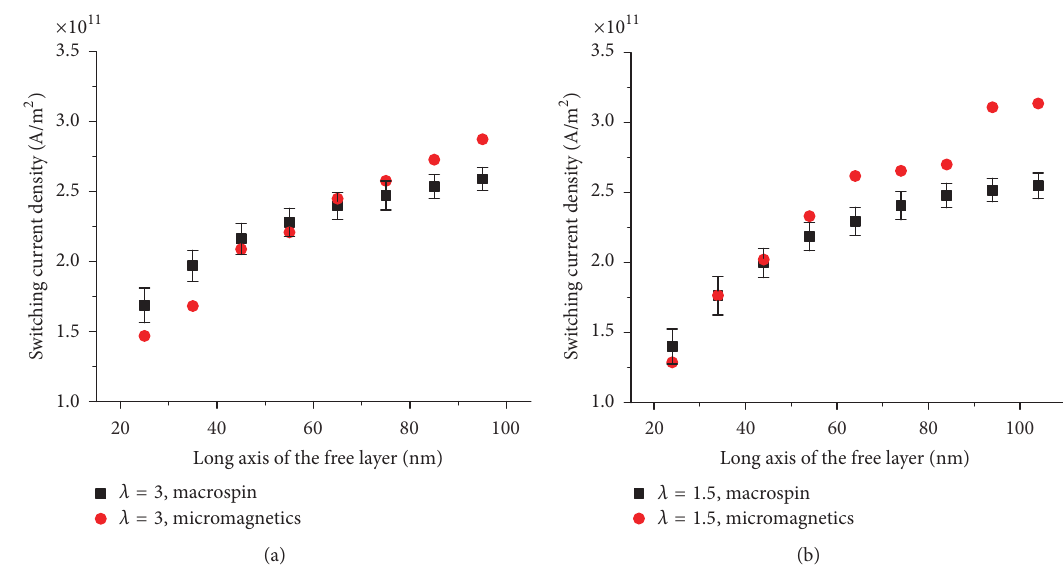
Figure 9: Current densities lead to magnetization switch in 5 ns in room temperature for free layers with (a) 𝜆 = 3 and (b) 𝜆 = 1.5.